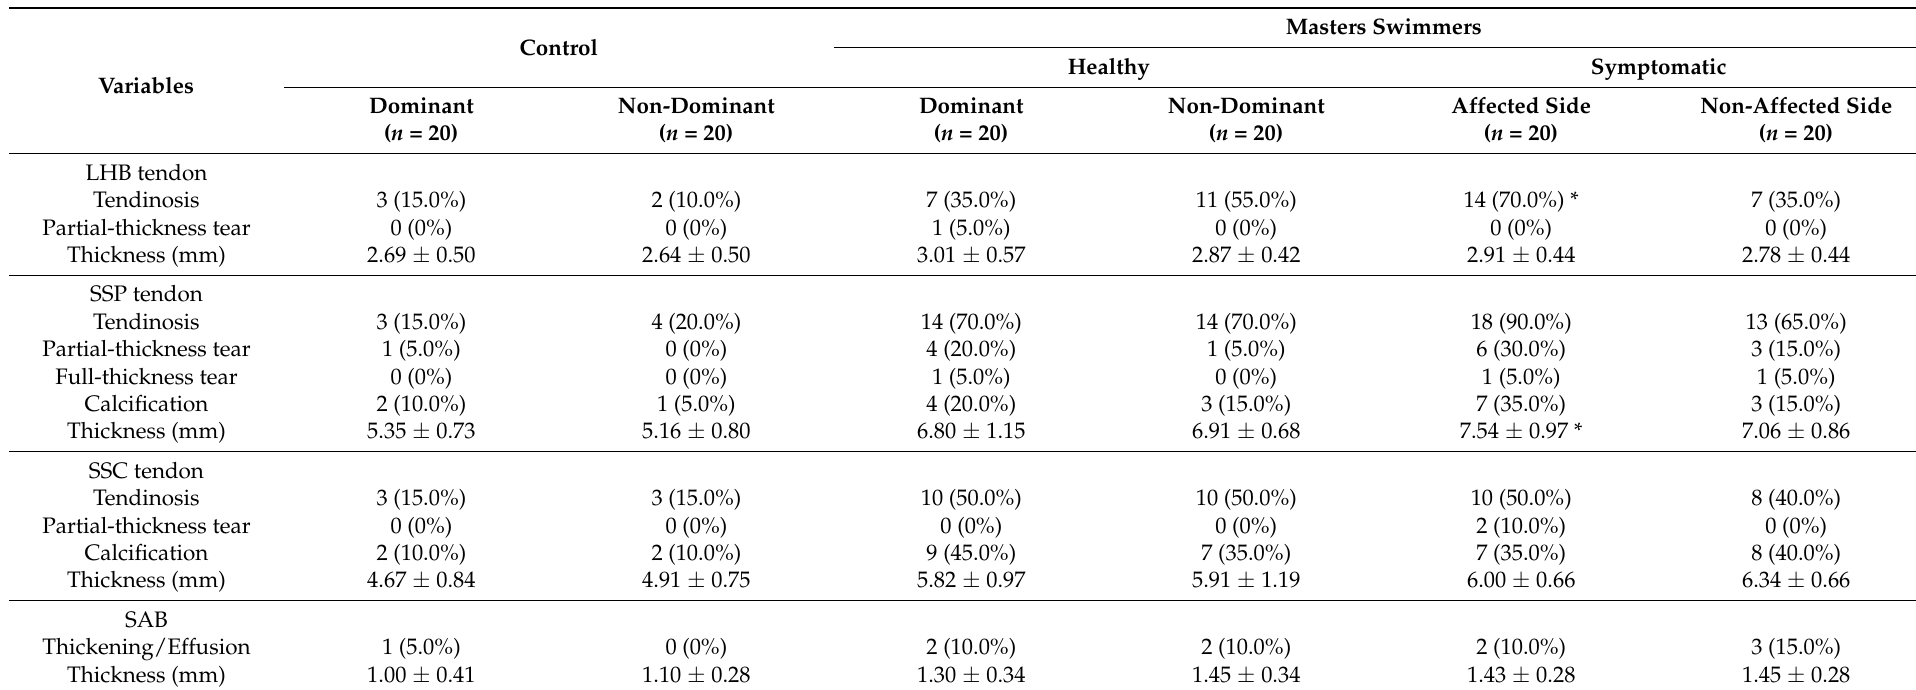
Table 2. Lateral differences in the prevalence of ultrasonographic findings and rotator cuff thickness within